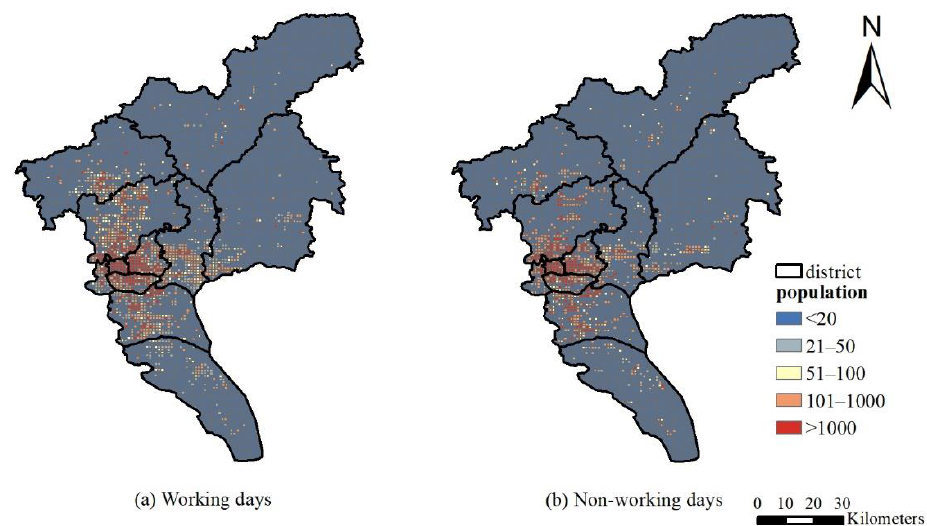
Figure 4. Dynamic population distribution in September 2021: ( a ) working days; ( b ) non-working days. The distribution of Guangzhou’s population exposure intensity in 2015 is shown in Figure 5. The areas with high average exposure risk in 2015 were concentrated in the Liwan District, Yuexiu District, Haizhu District, and Tianhe District of Guangzhou City. In contrast, the Conghua District and Zengcheng District have lower exposure